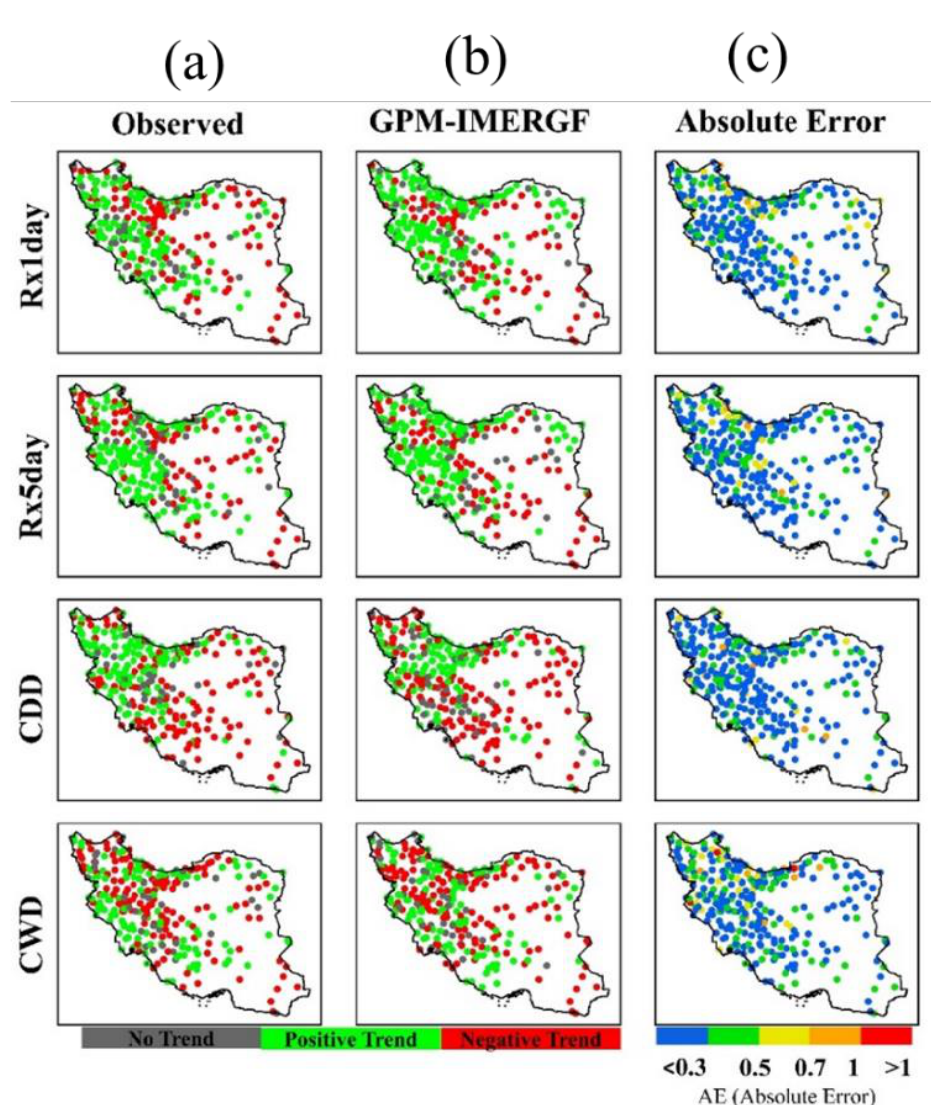
Figure 8. Maximum precipitation indices trends based on GPM-IMERGV6.0 Final Run (GPM- IMERGF) dataset and the observed data. ( a – c ) are observational trends, GPM-IMERGF estimated trends, and absolute error between estimated Tau Kendall (Z score) and observed ones,